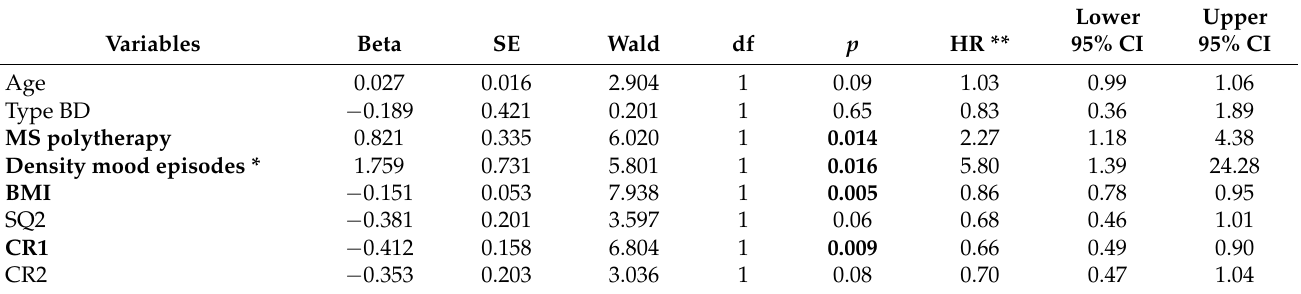
Table 3. Multivariable survival analysis (Cox regression model) using actigraphy